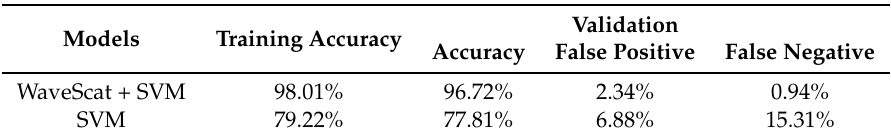
Table 5. Accuracy and confusion results of vertical traces (considering surface roughness) with or without wavelet scattering networks in the machine learning model.